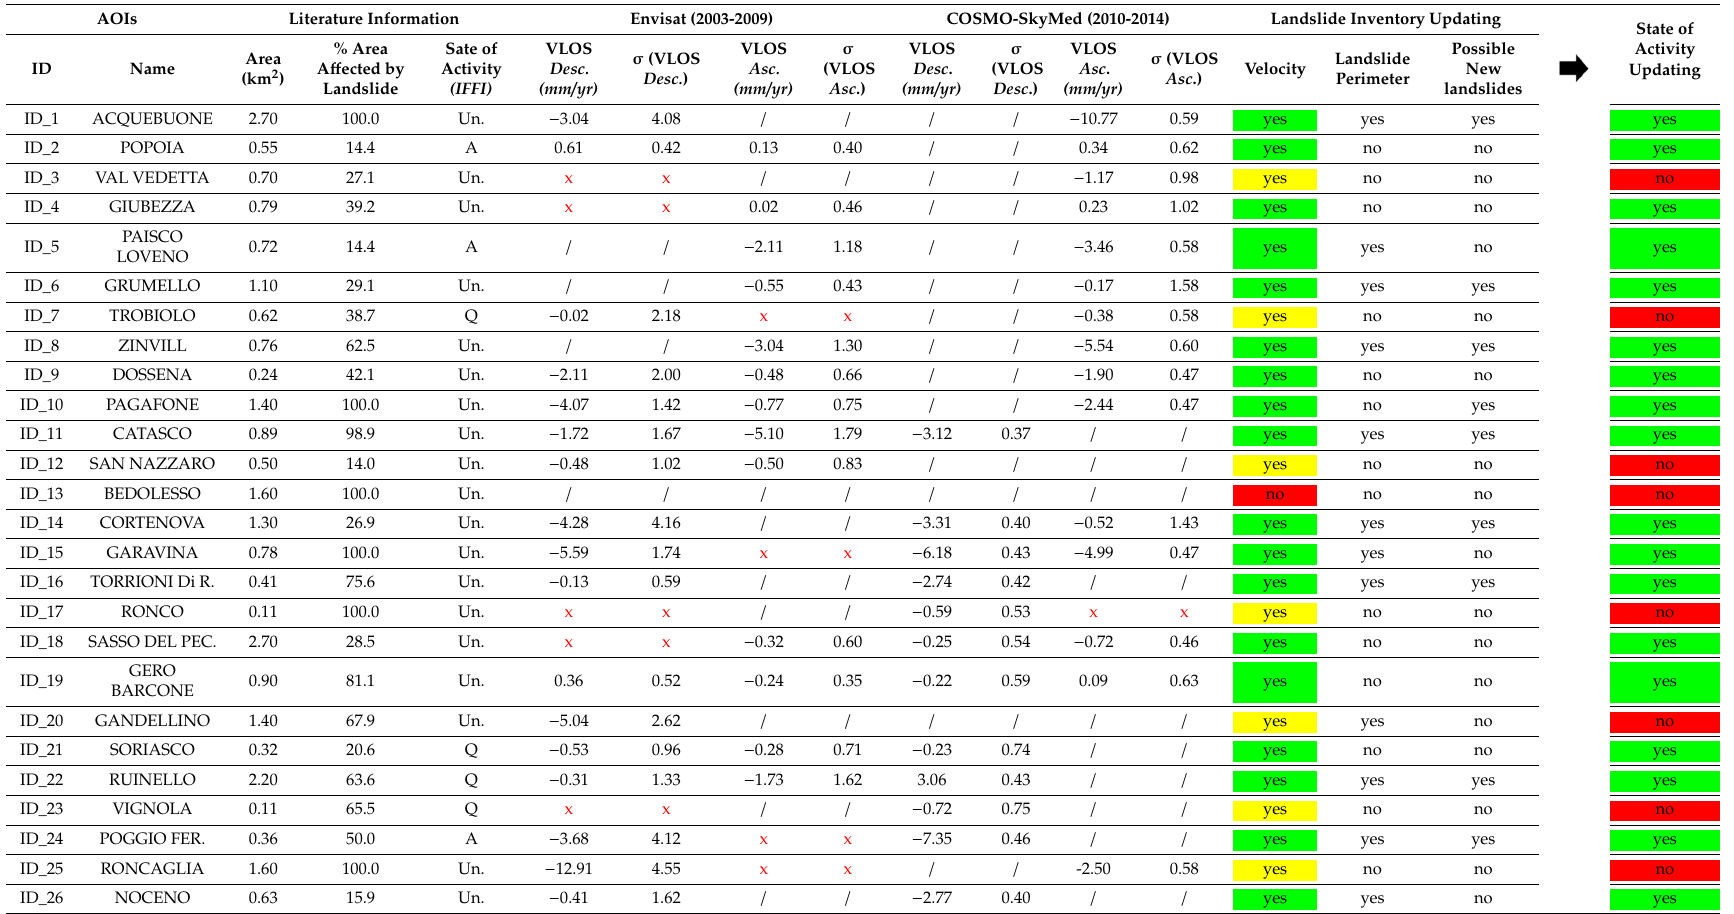
Table 3. Summary and statistics of the A-DInSAR results with respective reference years, and the related updating of landslide inventory (IFFI, 2007). State of activity categories of the IFFI inventory: (A) activated, reactivated, suspended; (Un) undefined; (Q) quiescent. Vlos DESC: Velocity (LOS direction) of the descending dataset; Vlos ASC: Velocity (LOS direction) of the ascending dataset; σ (Vlos): standard deviation of the velocity values. Red x: not reliable velocity values, i.e., values calculated on a N° PS ≤ 10; slash: satellite data not available. Green: possibility to update the inventory; yellow: reliable data but insufficient information to update the inventory; red: data not available or failure to update inventory.